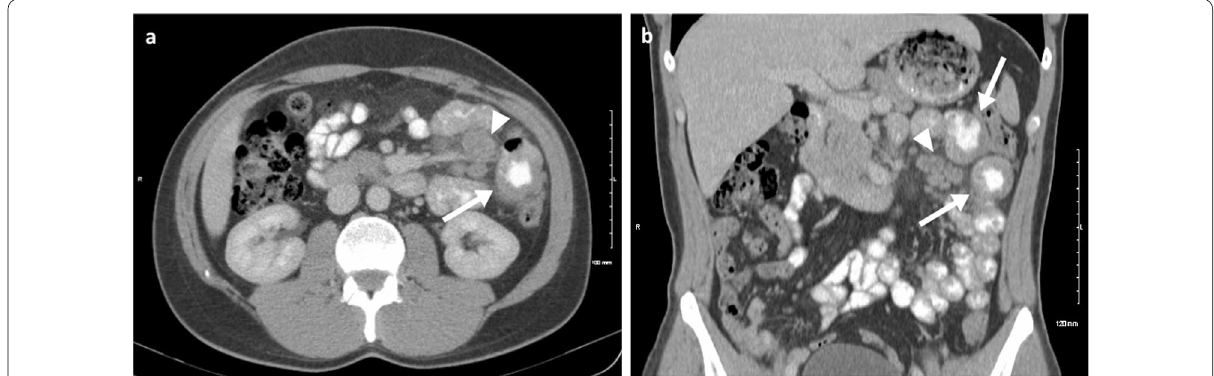
Fig. 1 Case report: oral and intravenous portal phase contrast-enhanced CT axial ( a ) and coronal ( b ) of a 33-year-old male patient diagnosed with left lower eyelid melanoma which subsequently metastasised to the lymph nodes, lungs, brain, SB and subcutaneous tissue in the following 5-year period. Complete response was achieved after chemotherapy, immunotherapy and radiotherapy. One year after treatment completion he relapsed, presenting with two jejunal metastases (arrows) and involvement of the draining mesenteric lymph nodes (arrow heads). Surgical resection was then performed with no evidence of disease recurrence to date, after 10 years of